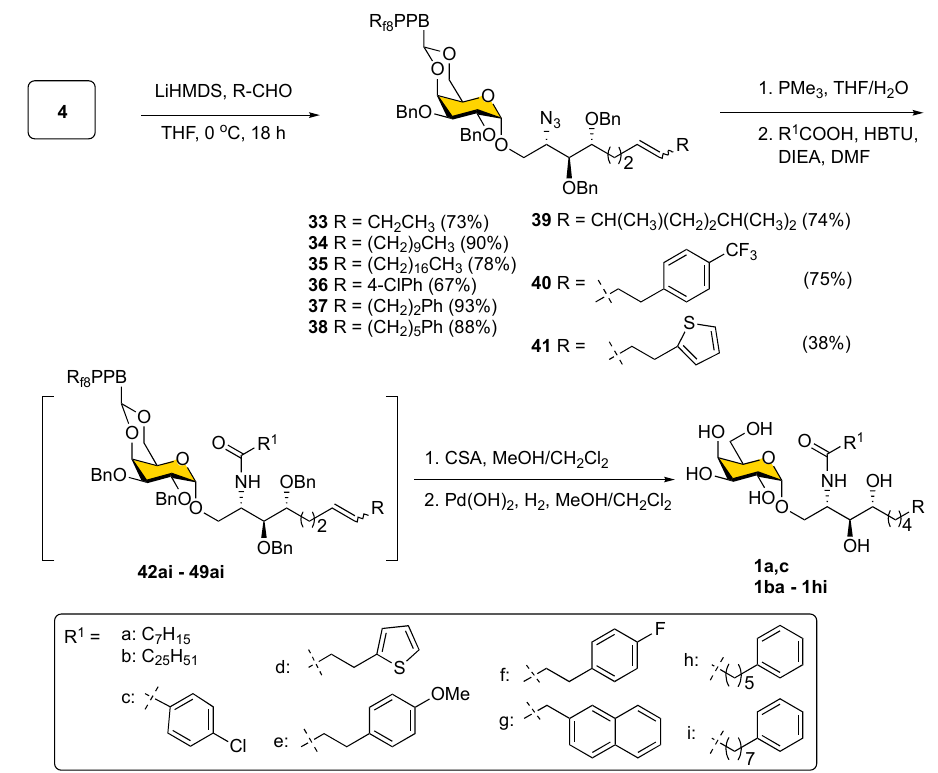
Scheme 7. Construction of an α -GalCer glycolipid library ( 1 ).